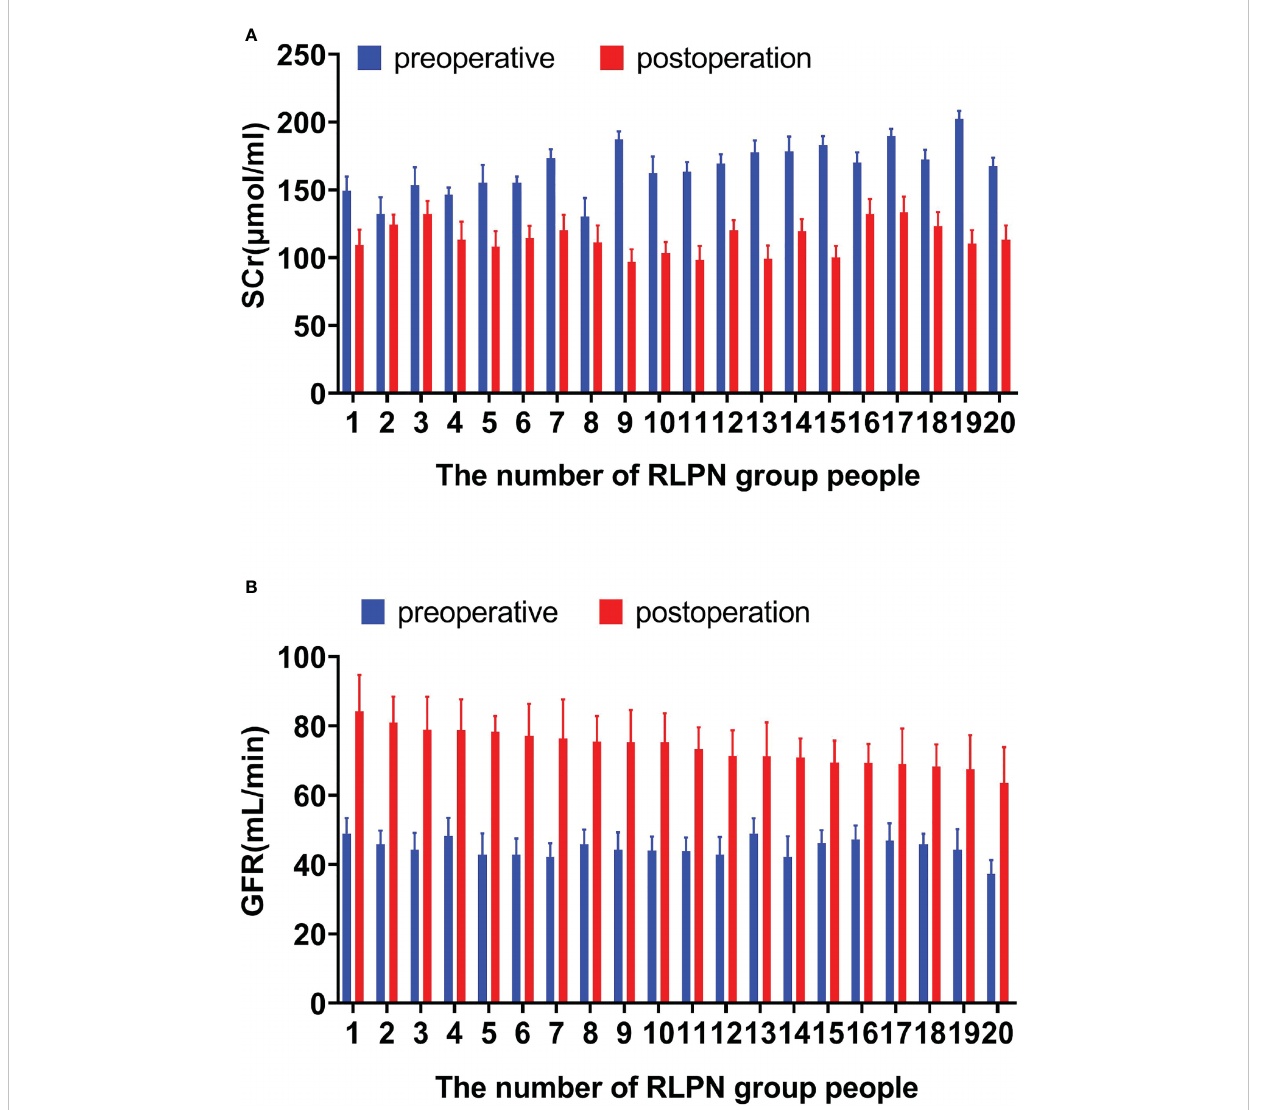
FIGURE 2 The level of SCR (A) and GFR (B) in the RLPN